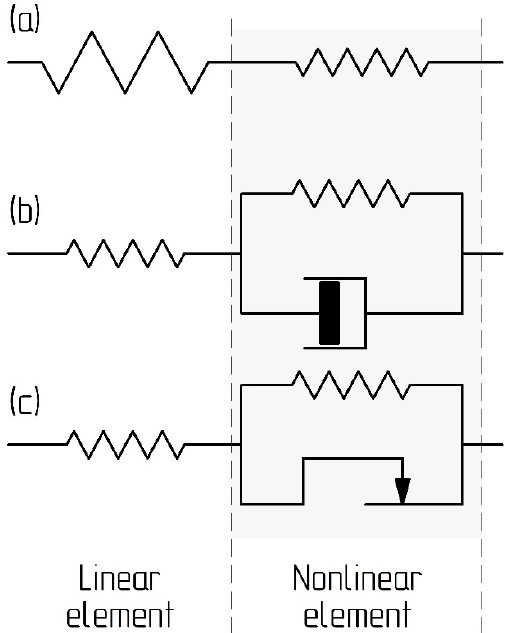
Figure 2. Models describing the nonlinearity of permeability as a function of effective pressure: ( a ) TPHM; ( b ) model with friction element; ( c ) model with viscous element. With creep, the decrease in permeability is a consequence of the decrease in